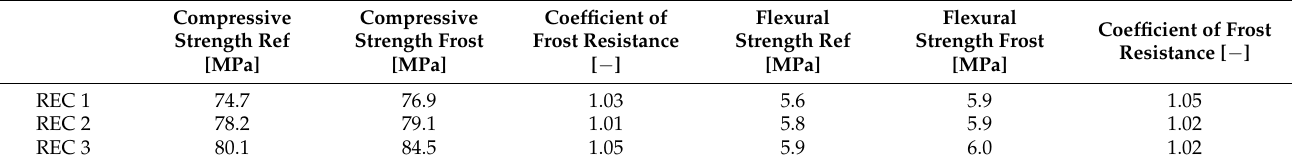
Table 10. Results of mixtures properties after 100 cycles of frost resistance.